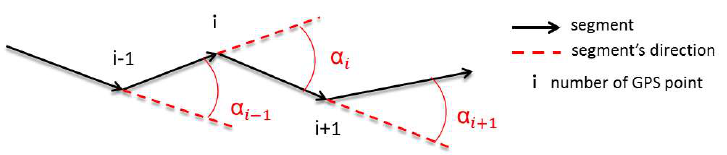
Figure 4. AngleMean calculation; α i represents the angle between the segment starting at point i and the segment starting at point i − 1.